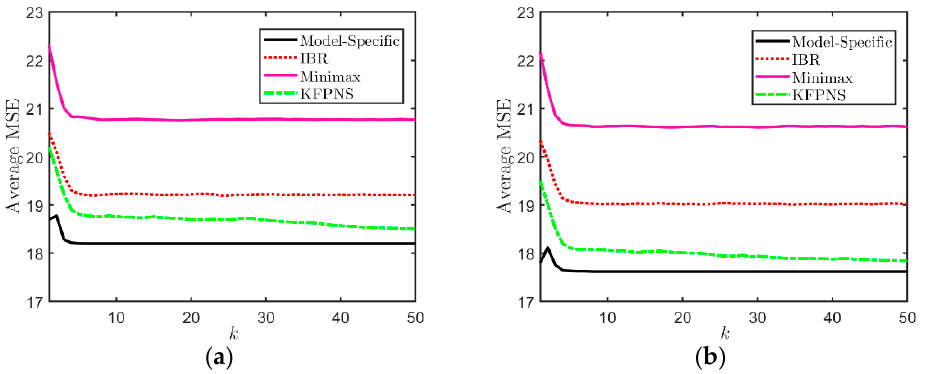
Figure 5. The average performance of four filters with different Beta priors. ( a ) α r = 0.1, β r = 0.9; ( b ) α r = 0.01, β r = 0.09.